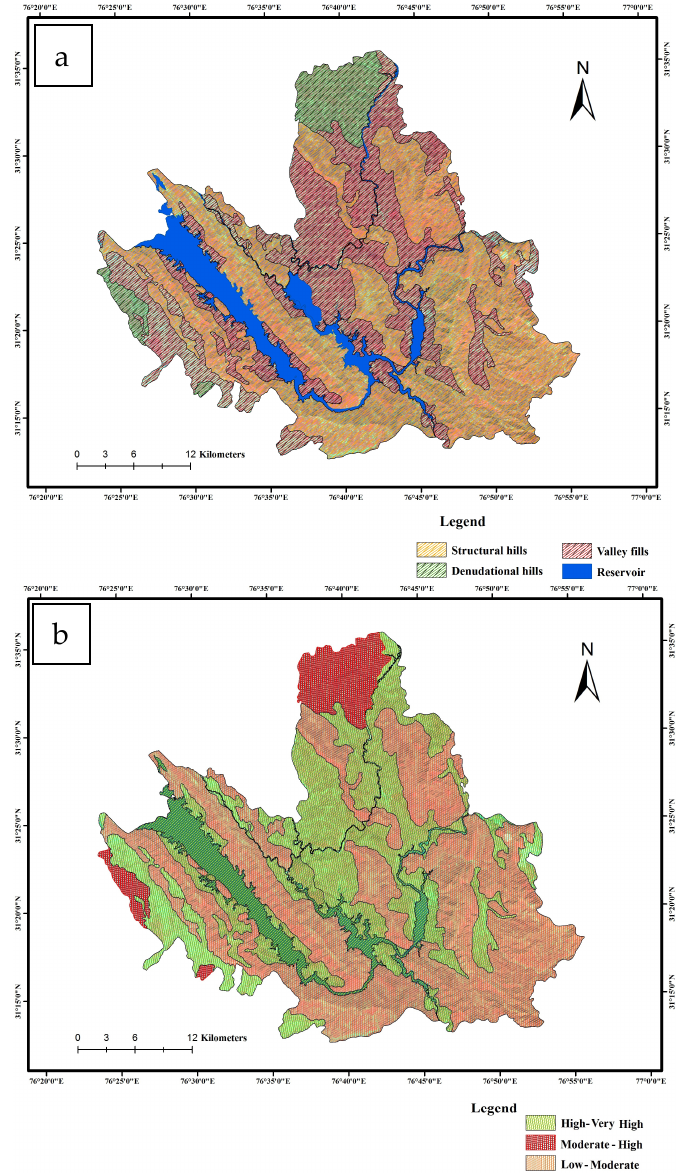
Figure 13. ( a ) Geomorphology map of Bilaspur district; ( b ) Geomorphology index map of Bilaspur district.